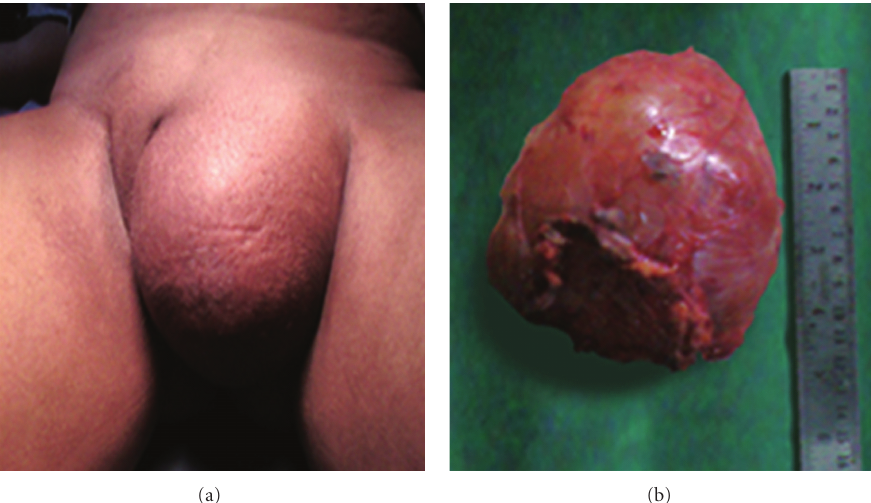
Figure 1: (a) Preoperative picture showing soft tissue mass arising within left labium major. (b) Encapsulated tumor after excision.